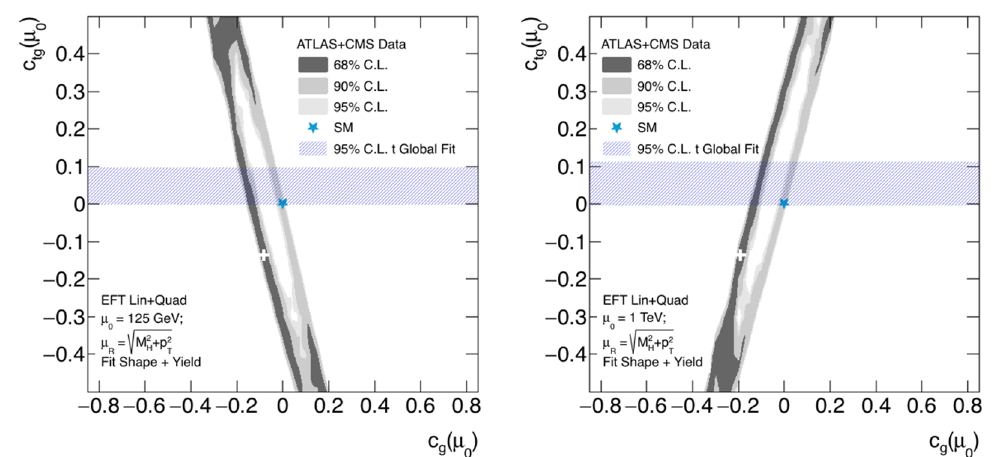
Figure 14. Constraints on the c g and c tg coefficients at 68% (dark grey), 90% (mid grey) and 95% (light grey) C.L. obtained from the simultaneous fit to ATLAS and CMS data for µ 0 = 125 GeV (left panel) and µ 0 = 1 TeV (right panel). The SM value is indicated by the blue star and the best fit value by the white marker. The shaded horizontal strip indicates the 95% C.L. interval for c tg from the top quark fit of ref. [71] translated to our definition of c tg ( µ 0 )